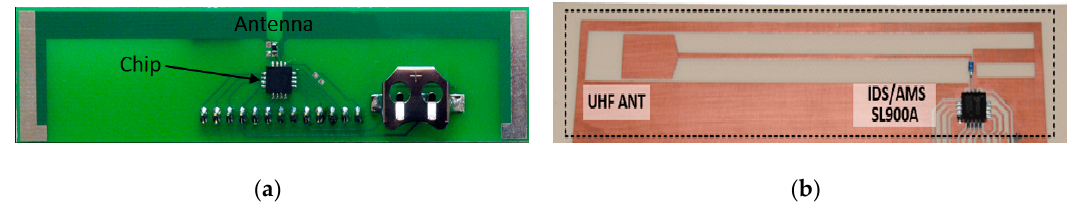
Figure 23. UHF RFID transponders used in experiments: ( a ) Project with omnidirectional antenna; ( b ) Project with directional antenna.